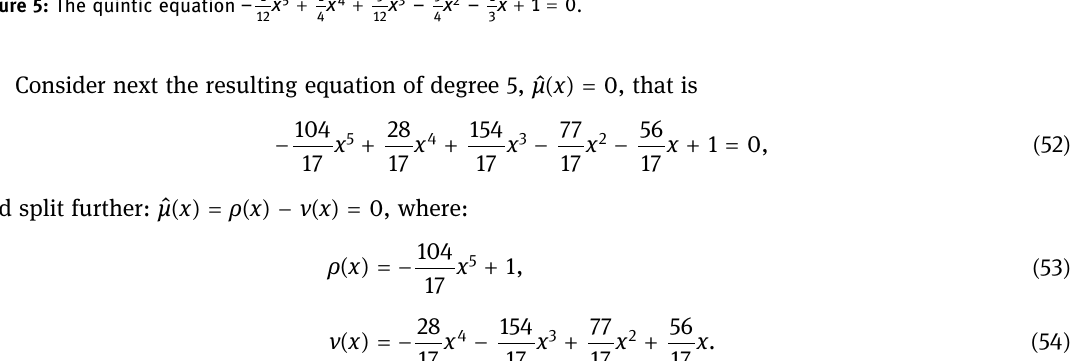
Figure 5: The quintic